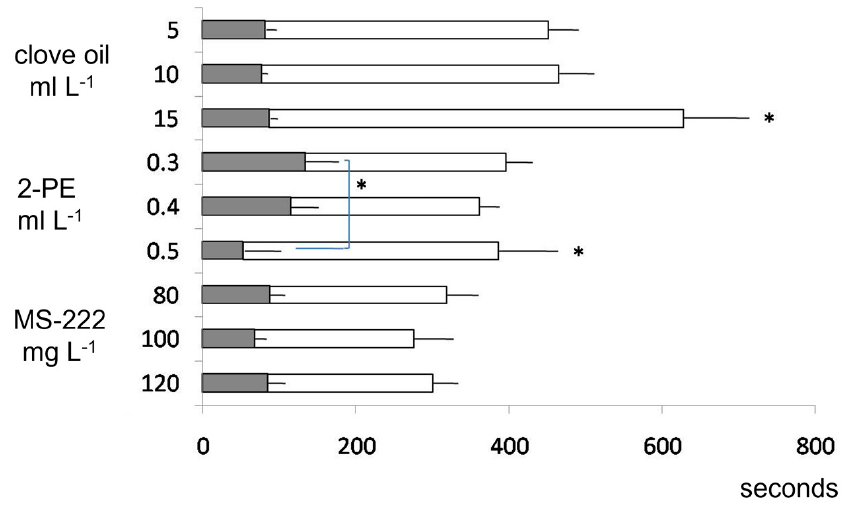
Figure 1. The response of juvenile cobia to three different anesthetics presented at three different doses. The gray colored series for each dose represents time to stage 5 anesthesia whereas the white series represents time to full recovery from anesthesia. Bars are ± S.D. Doses are in mL L − 1 for clove oil and 2-phenoxyethanol and mg L − 1 for MS-222. Asterisks indicate significant differences for individual anesthetics at the α = 0.02 level.